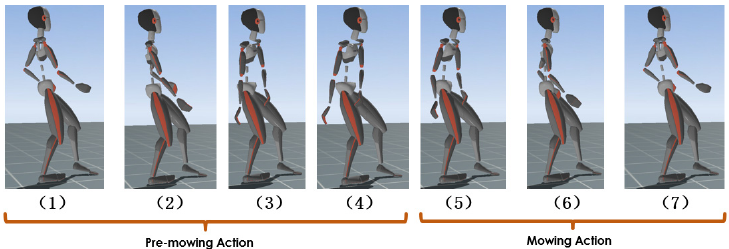
Figure 1. The Pre-cutting Behaviors in this Study.